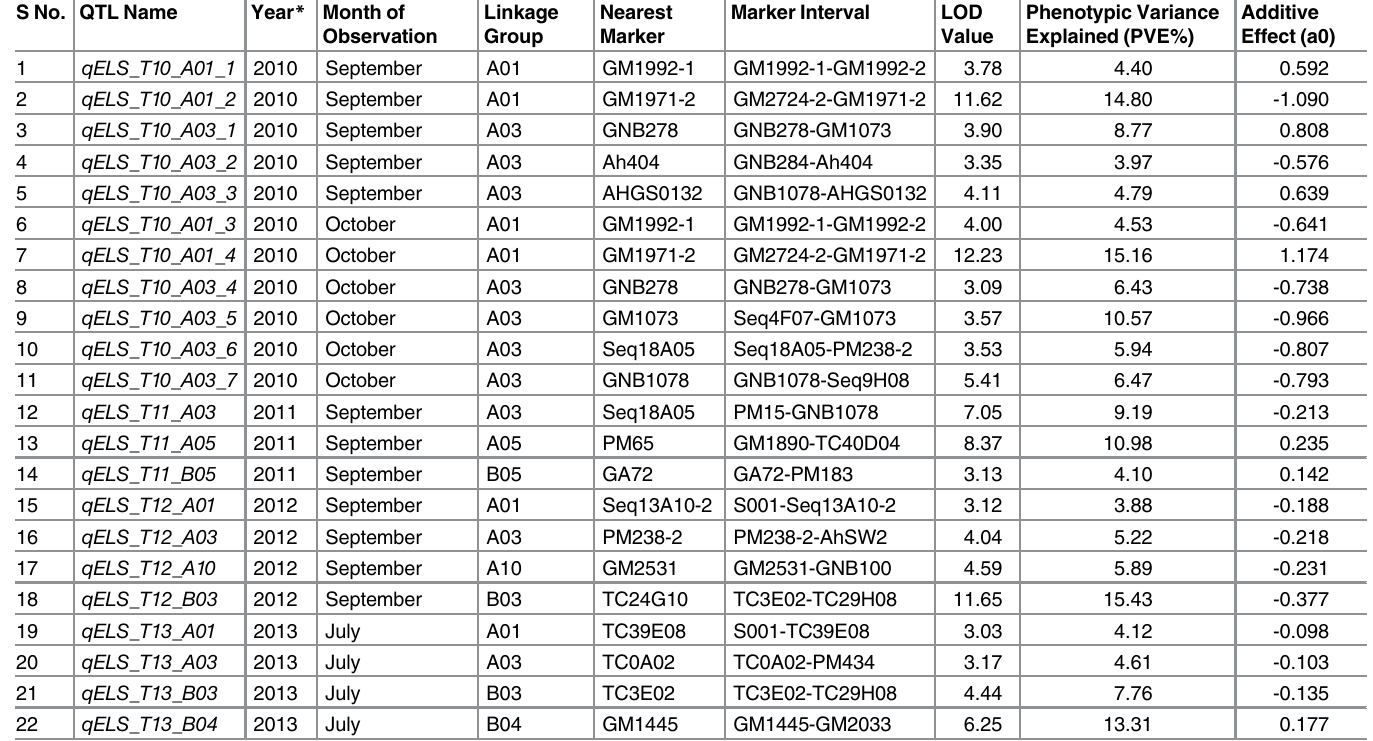
Table 5. QTLs identified for early leaf spot (ELS) resistance in